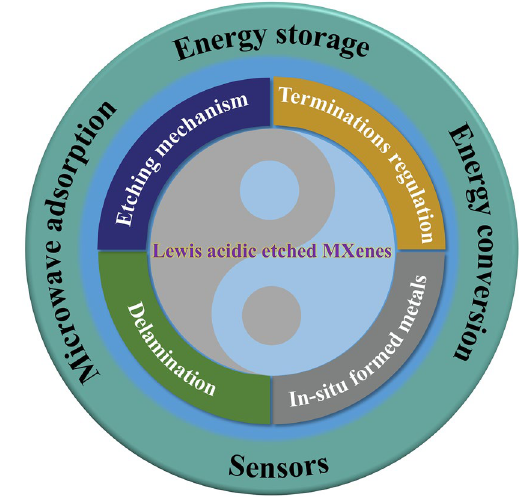
Fig. 4 An overview demonstrating the Lewis acidic etching